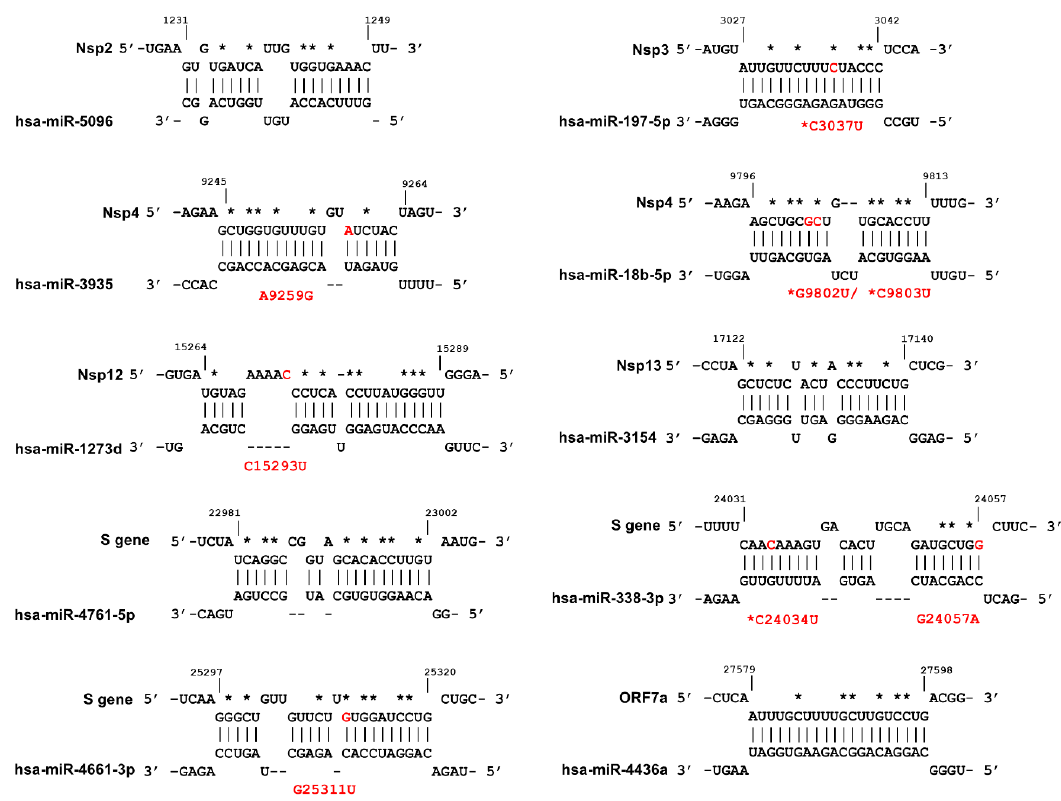
Figure 5. Prediction of host miRNAs binding sites within different regions of SARS-CoV-2 genome. The mutations that occur in miRNA binding sites are indicated in red, and the designations of the mutations are shown in red font. Conserved mutations are indicated with red asterisks while the nucleotide substitutions that result in significant effect on MBS are shown with black asterisks. The figure was produced using IntaRNA tool.